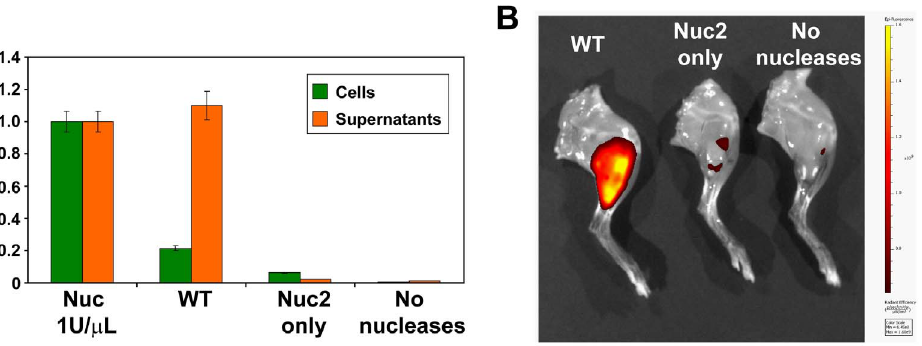
Figure 6. Nuc2 activity is detectable in mouse infections. A . Activation of the TT probe by recombinant micrococcal nuclease (left) or spent culture media (orange) or cell suspensions (green) of S. aureus WT, a strain only expressing Nuc2 ( nuc mutant), and strain without nucleases ( nuc nuc2 double mutant). B . TT probe activation at infection sites of leg muscle tissue of mice bearing infections with the same three strains. This image is representative of 3 independent experiments.